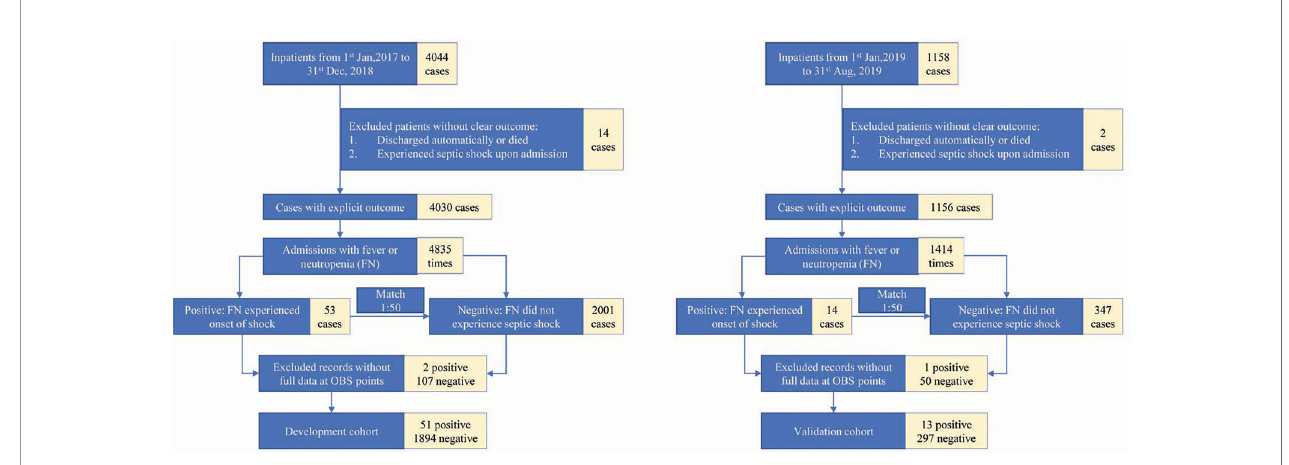
FIGURE 2 | Flow chart of establishing development and validation cohorts.